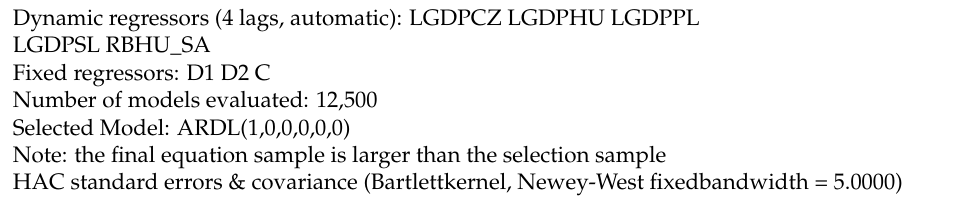
Table A2. HungaryARDL (1,0,0,0,0,0) Model Result of Import.